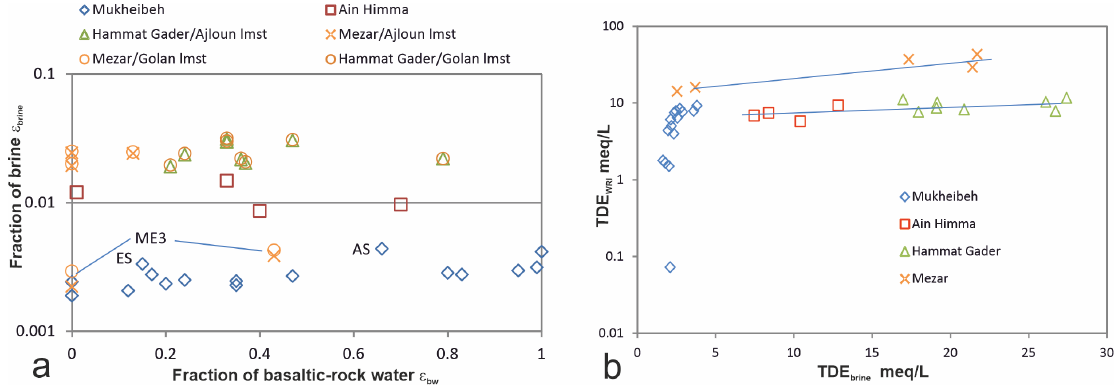
Figure 8. Cross plots of (a) ε bw and ε brine and (b) TDE brine and TDE WRI . These data are obtained under the assumption that ε brine can be estimated after Equation (2). Hammat Gader and Mezar data are based on Golan limestone water and Ha’On brine. Muhkeibeh water is related to